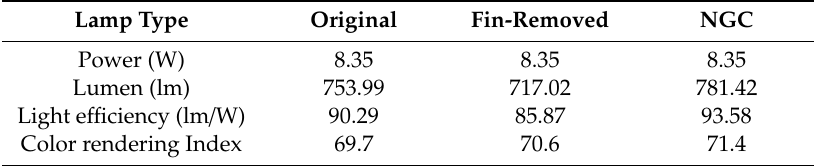
Table 8. Properties for the di ff erent LED types. Lamp Type